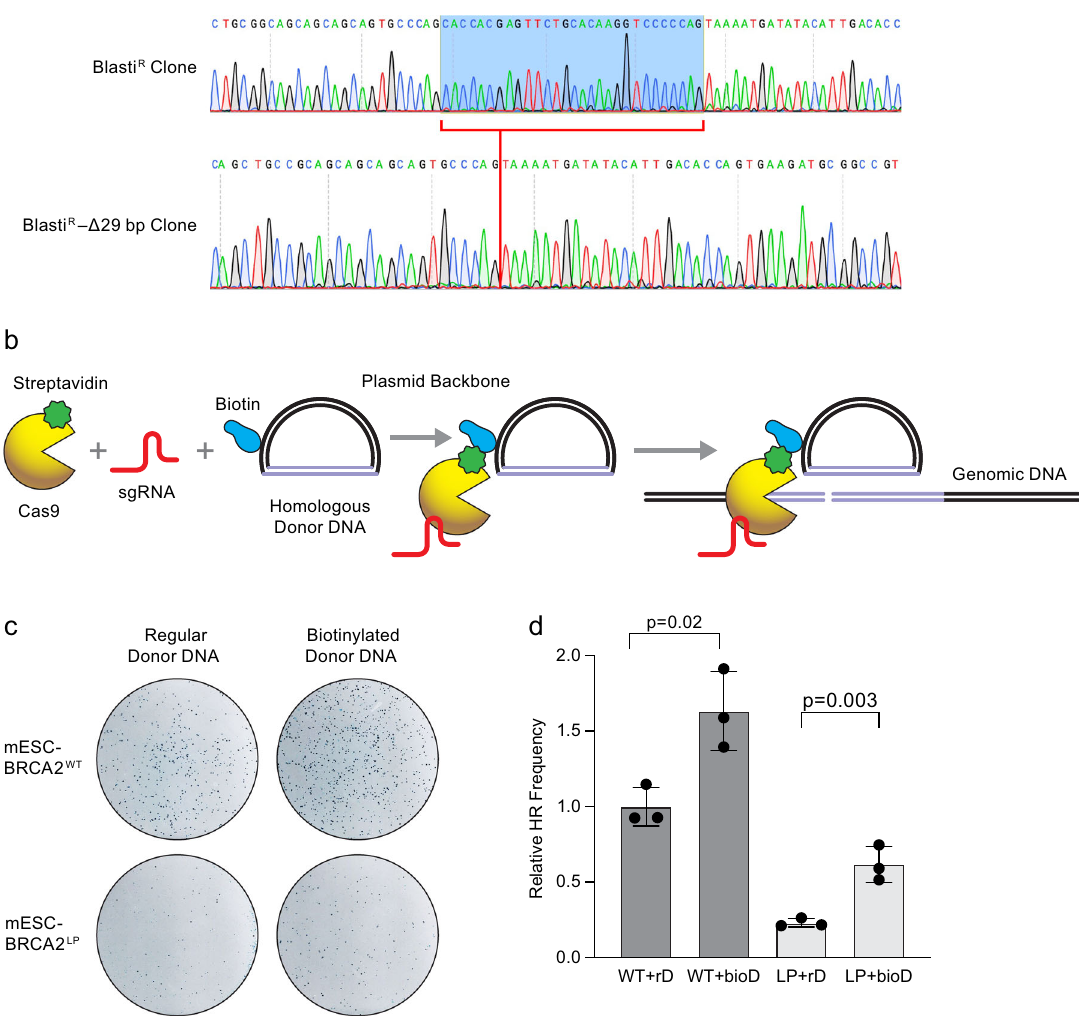
Fig. 6 CRISPR Cas9-based assay to determine HR ef fi ciency. a Chromatograms (reverse complementary strand) showing full-length and 29 bp deletion in the blasticidin resistance gene which renders the cells sensitive to blasticidin. b Schematic representation of streptavidin-tagged Cas9-mediated delivery of biotinylated donor DNA near to the DSB (generated by Cas9) to assist HR. c Representative plates showing mESC colonies obtained in WT and BRCA2 L2510P complemented Brca2 KO/KO mESCs after HR-mediated repair of mutant blasticidin-resistance gene provided with regular or biotinylated donor DNA. d Quanti fi cation of relative HR ef fi ciency in BRCA2 WT and BRCA2 L2510P expressing mESCs. Number of blasticidin-resistant colonies are normalized to colonies in plates without selection, rD: regular donor, bioD: biotinylated donor (see Supplementary Fig. 9b, n = 3 technical replicate, two-tailed Student ’ s t test, error bar- SD of